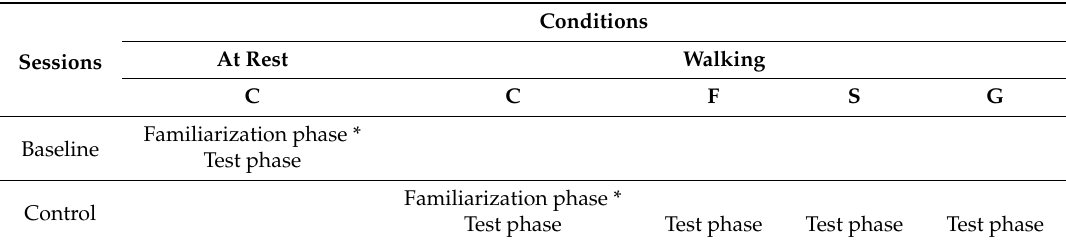
Table 2. Experiment protocol